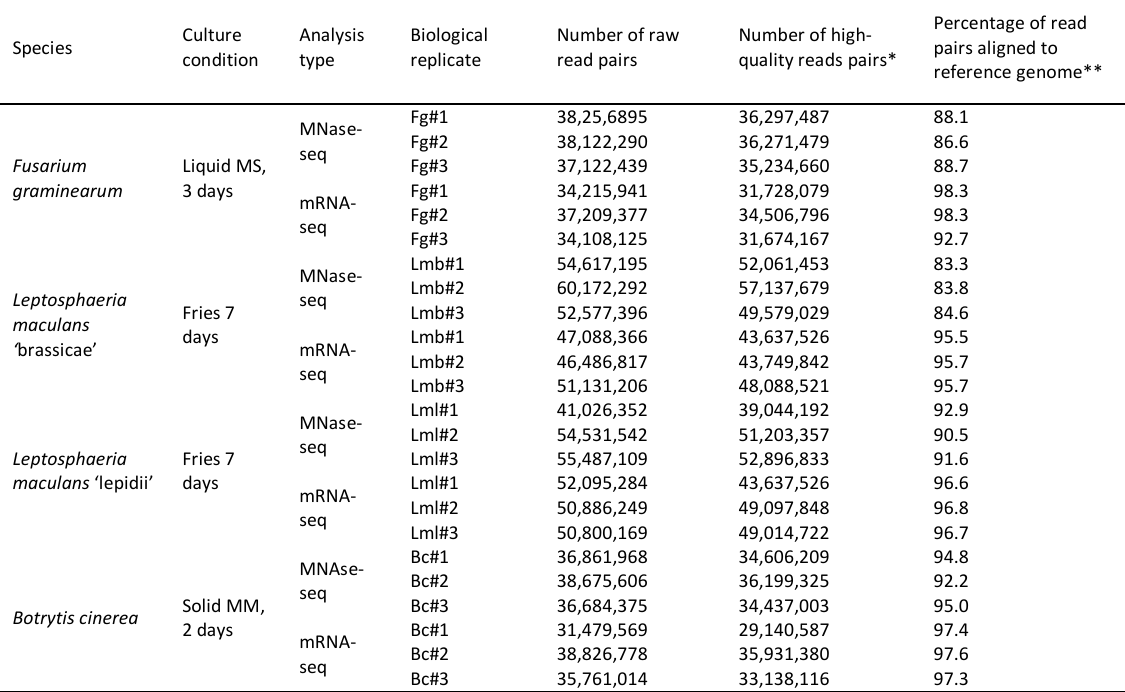
Supplementary Table 1 . Summary of sequencing and mapping metrics